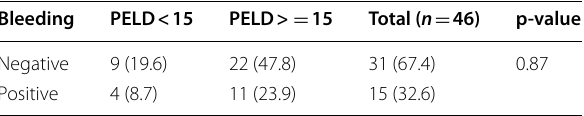
Table 5 The relationship between bleeding and different levels of liver cirrhosis based on PELD Bleeding